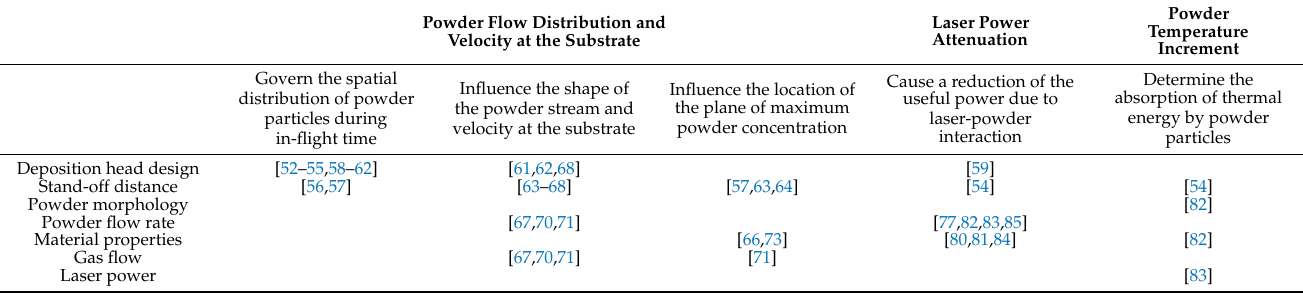
Table 3. Summary of the factors influencing laser irradiation and material addition